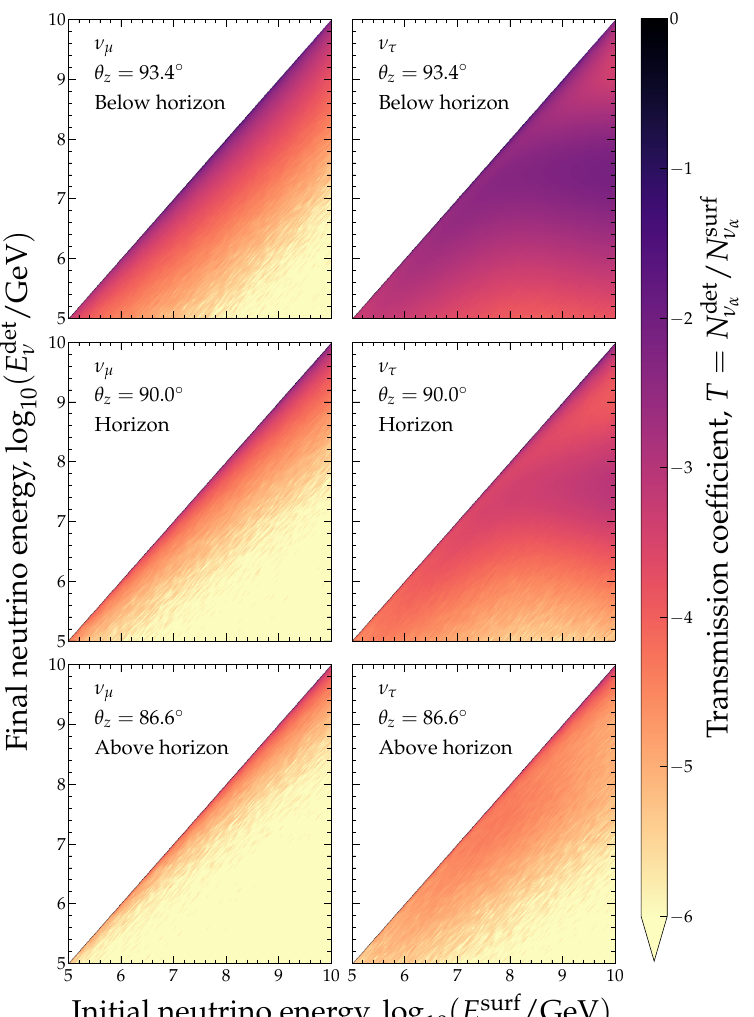
(cos θ ) /N surf of ultra-high- surf , E det z , E ν α ν ν ν α , a number ν , is injected at the surface of the ν . ν , in the notation of std